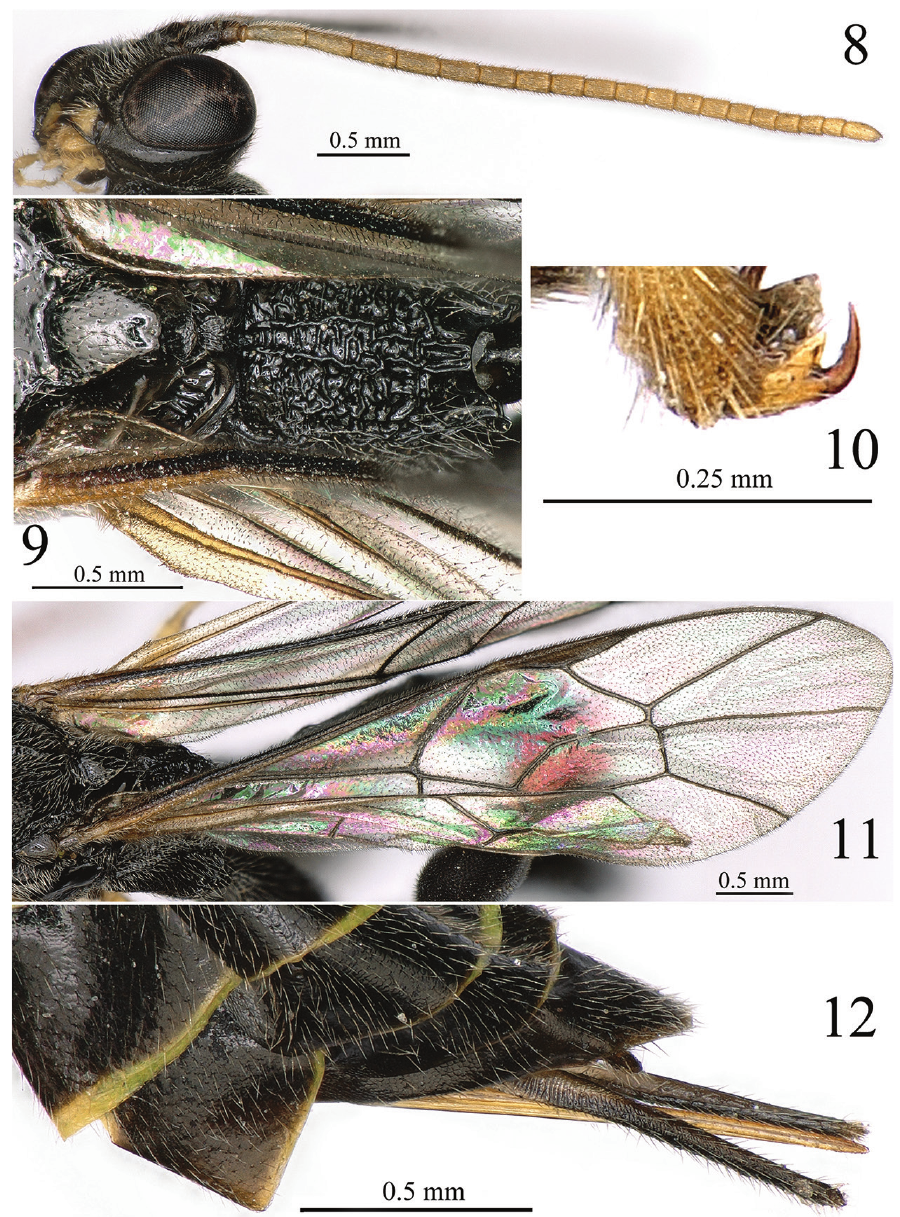
Figures 8–12. Bicurta hejunhuai sp. nov. (female holotype) 8 head and antenna, lateral view 9 scutellum and propodeum, dorsal view 10 mid claw, lateral view 11 fore wing 12 apex of metasoma and ovipositor, lateral